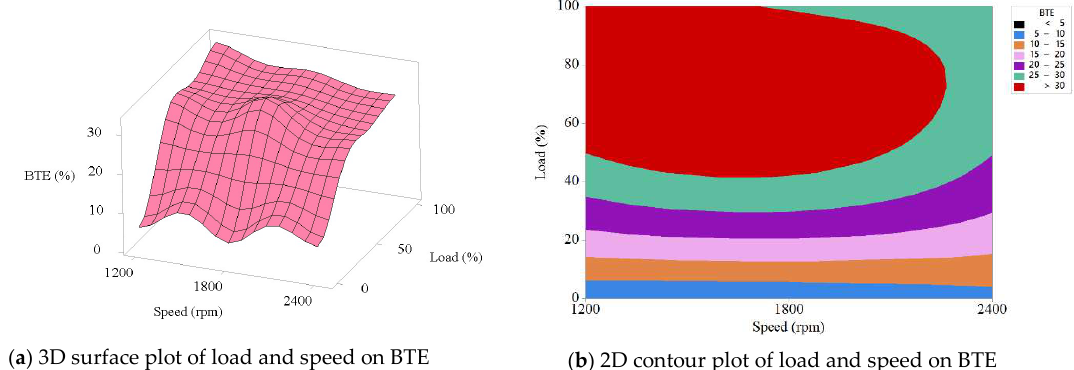
Figure 9. Combined effects of biodiesel blends, load, and speed on BTE (%).